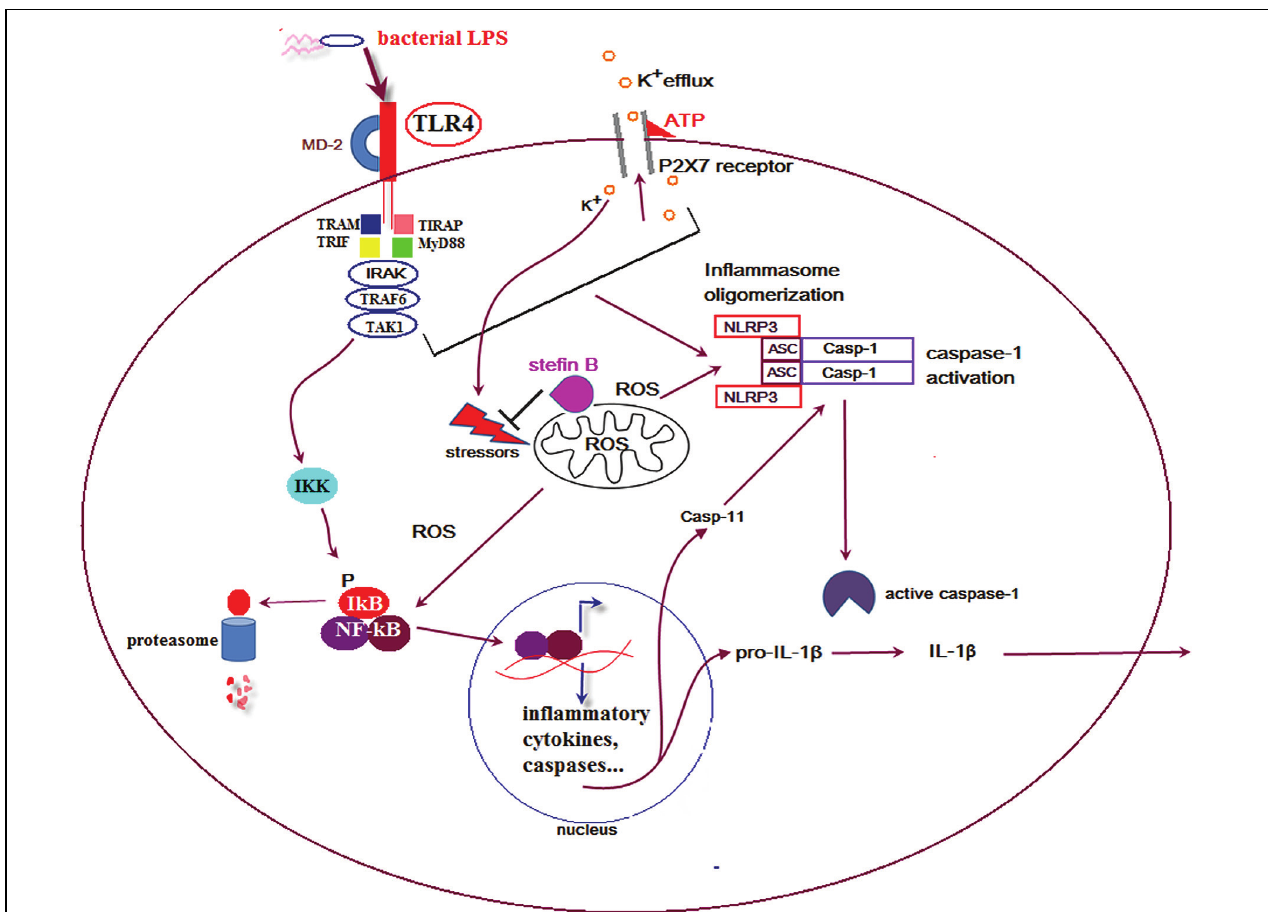
FIGURE 1 | Proposed model for the role of stefin B in non canonical inflammasome activation. Upon lipopolysaccharide (LPS) stimulation stefin B is translocated from cytosol into mitochondria and protects mitochondrial membrane integrity. Stefin B deficiency resulted in the breakdown of mitochondria membrane potential and increased mtROS generation. The consequence of the increased mtROS detected in stefin B-deficient bone marrow-derived macrophages (BMDMs) upon LPS stimulation, was the increased nuclear factor- κ B (NF- κ B) activation and caspase-11 expression. Increased caspase-11 expression resulted in increased inflammasome activation and pro-inflammatory IL-1 β and IL-18 secretion.